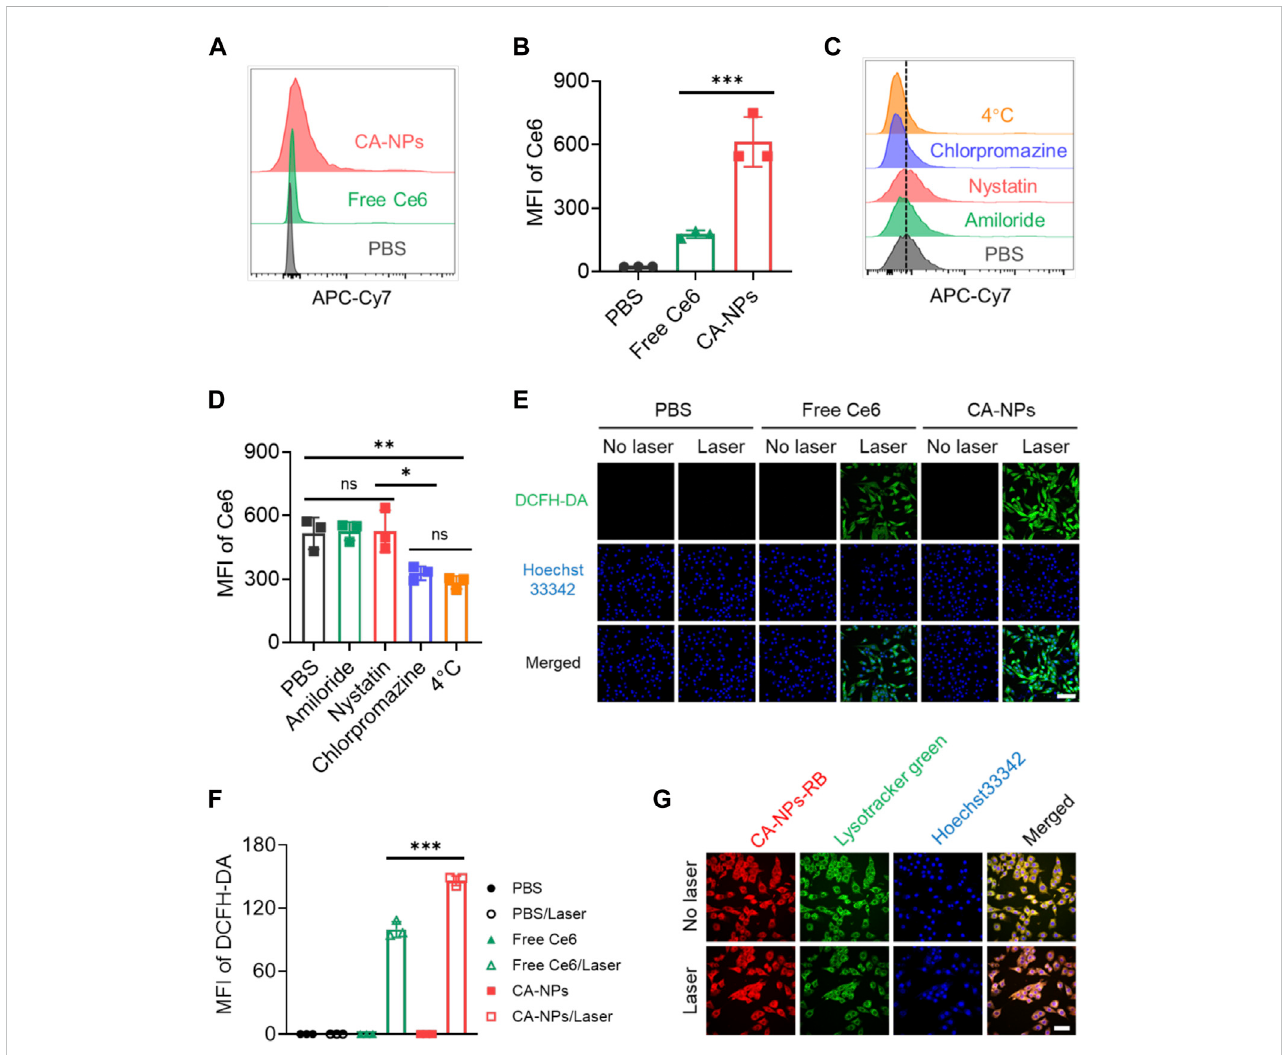
FIGURE 2 Cellularuptake,endocyticpathwayandsubcellulartranslocationofCA-NPs. (A,B) Flowcytometricquanti fi cationoftheuptakeofPBS,freeCe6andCA- NPs at the dose of 10 μ g/ml by MB49 cells for 24 h (C,D) Flow cytometric quanti fi cation of the uptake of CA-NPs by MB49 cells treated with PBS, amiloride, fi lipin and chlorpromazineat 37 ° C, and PBS at 4 ° C. (E,F) Intracellular ROS generation and MFI of free Ce6 and CA-NPs under 660 nm irradiation (0.15 W/cm 2 , 5 min) or not at the dose of 5 μ g/ml detected by DCFH-DA probe. Scale bar: 100 μ m. (G) Subcellular distribution of CA-NPs labelled with rhodamine B under irradiation or not. Scale bar: 50 μ m. (n = 3; ns: no signi fi cance, * p < 0.05, ** p < 0.01, *** p <